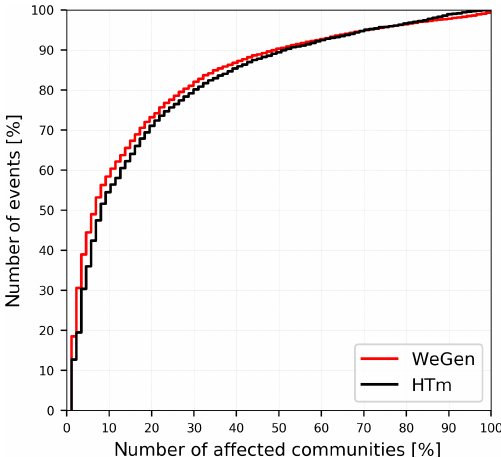
Figure 8. Relative number of flood events exceeding a 30-year flood threshold and corresponding relative number of affected communi- ties. The results are based on 30000 years of